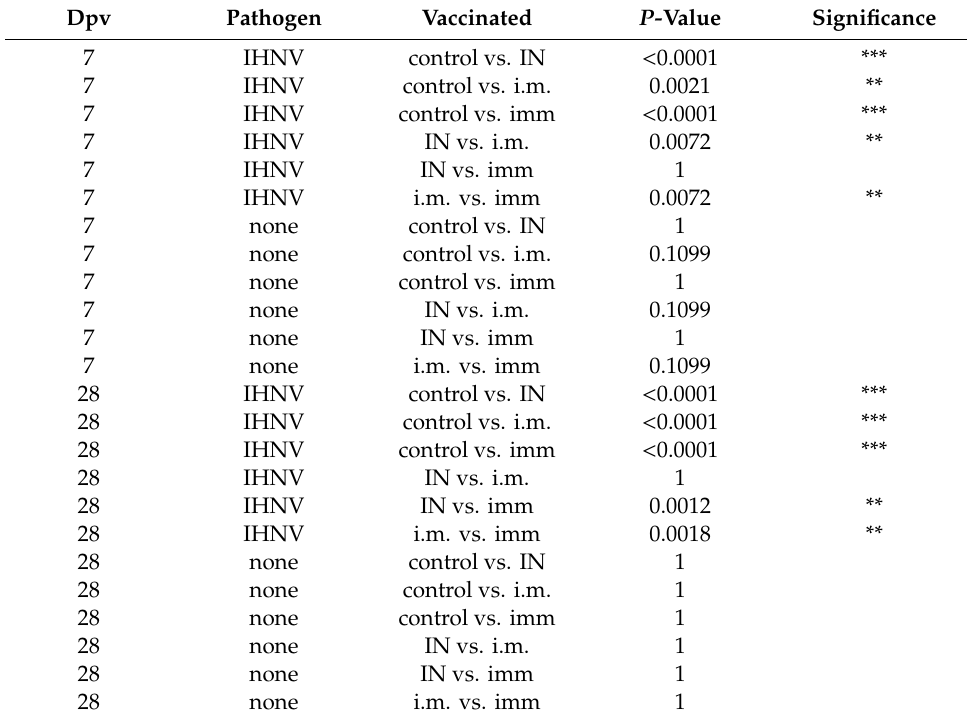
Dpv Pathogen Vaccinated P- Value Significance